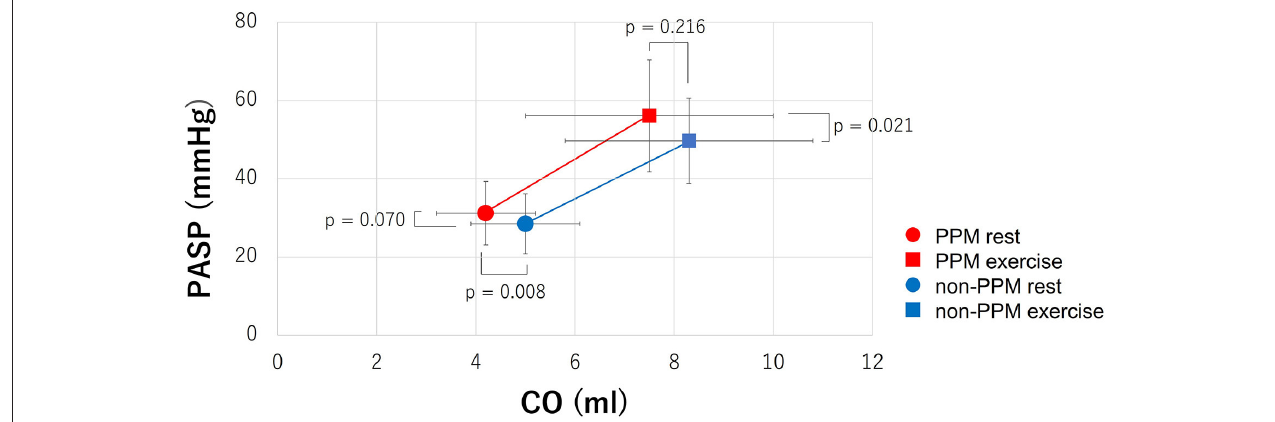
FIGURE 4 | The relationship between the SPAP and CO at rest and during exercise. The CO tended to be lower and the SPAP was higher in patients with PPM than in those without PPM both at rest and during exercise. The slopes showed that 1 SPAP/ 1 CO was higher in patients with PPM than in those without PPM, but the difference was not statistically significant (23.9 ± 45.9 vs. 8.9 ± 14.4, p = 0.202).SPAP = systolic pulmonary artery pressure; CO, cardiac output; PPM, prosthesis-patient mismatch; 1 SPAP/ 1 CO, the ratio of the change in SPAP and the change in CO.